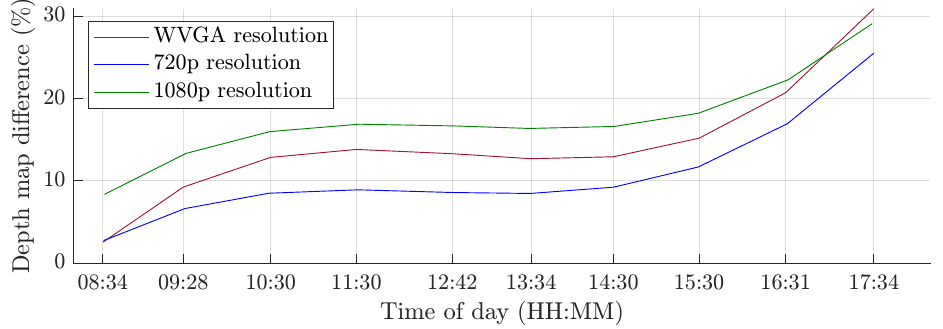
Figure 17. Influence of light changes during the